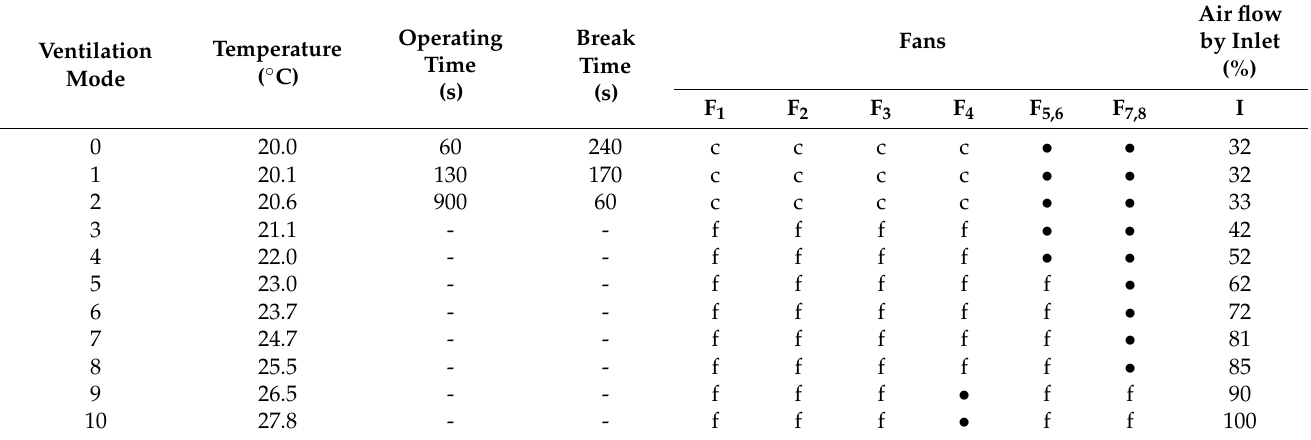
Table 1. The user setting of fans (c—operating mode on/off; f—continuous operation; • —fan